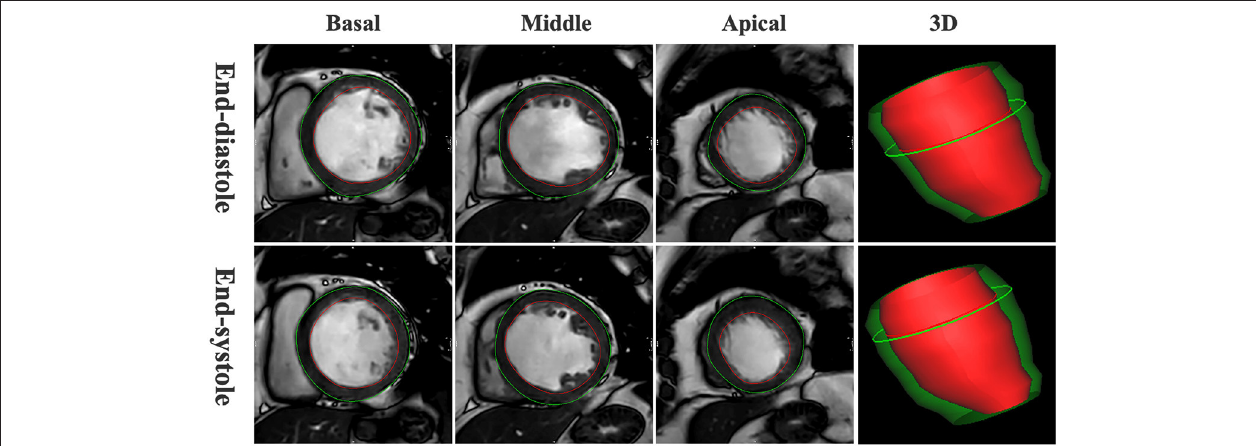
FIGURE 1 | Representative example of left ventricular global function index (LVGFI) in a patient with dilated cardiomyopathy. Endocardial (red) and epicardial (green) borders were drawn on the short-axis cine images from basal segment to apical segment and then three-dimensional (3D) model of the left ventricle in end-diastole and end-systole were generated